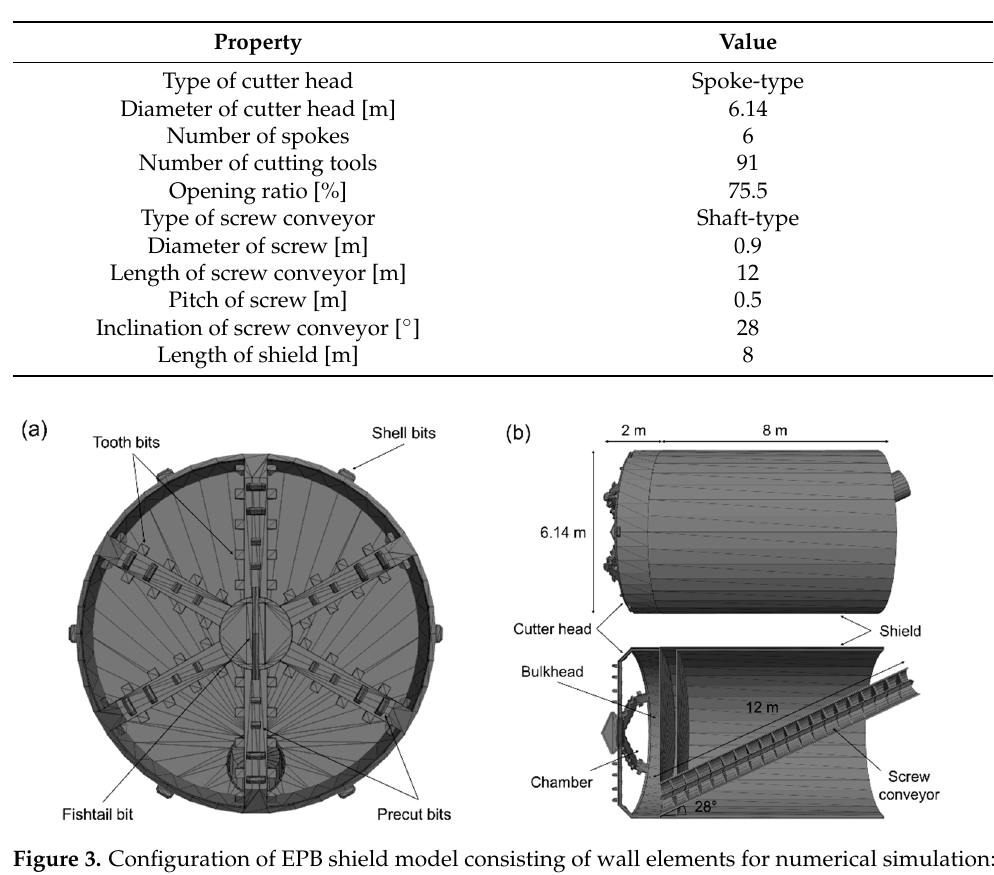
Table 3. Details of large-scale triaxial test model for calibration of contact parameters.